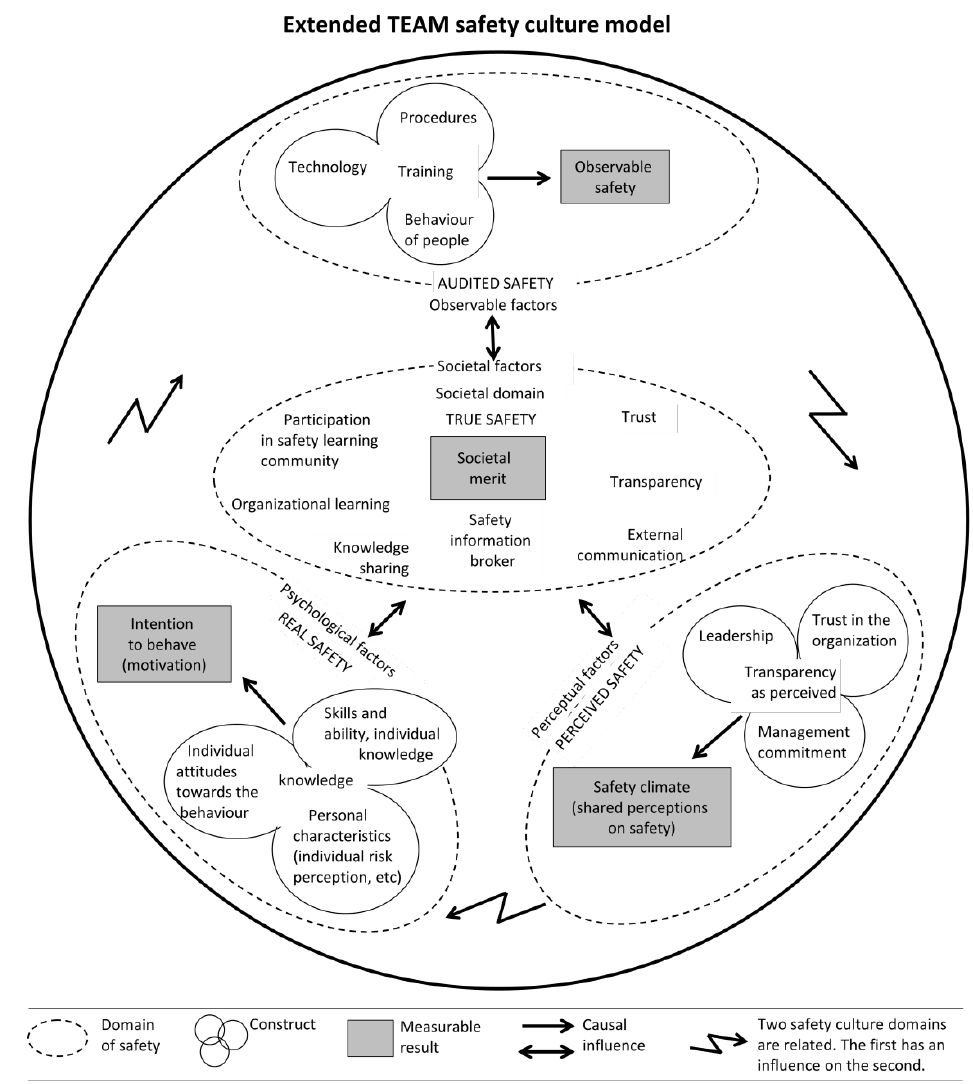
Figure 3. Extended TEAM safety culture model showing the proposed extension with a societal domain placed at its center.